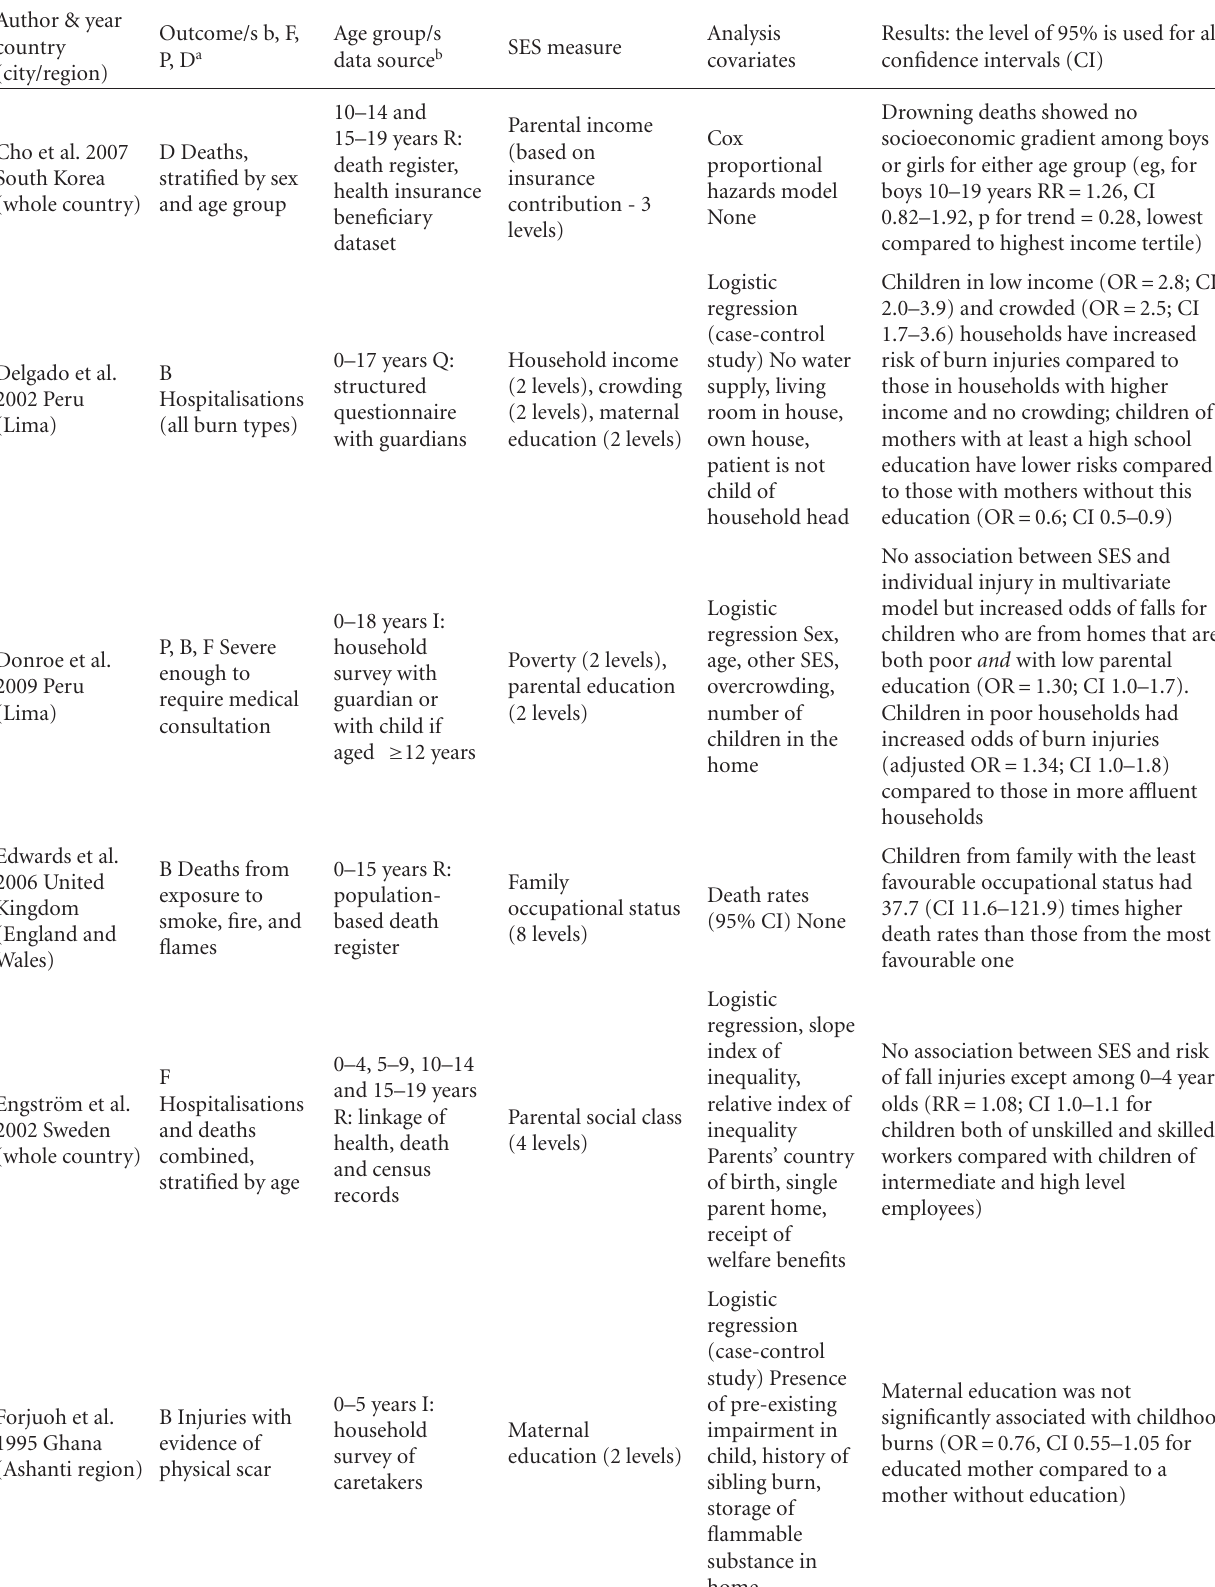
Table 5: Individual-level studies for childhood burn, fall, poisoning, and drowning injuries: summary of methodological features and results ( n =